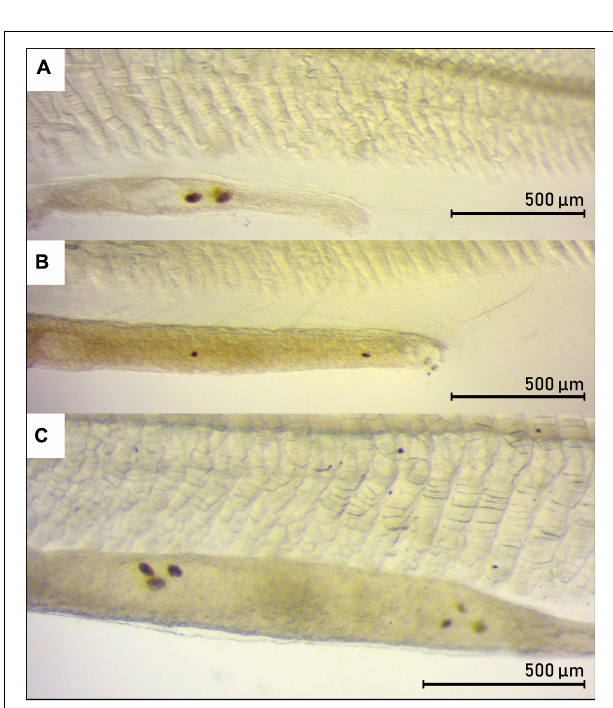
FIGURE 4 | Presence of food-like particles in the intestine of three leptocephalus larvae of the European eel ( Anguilla anguilla ). (A) L9 (SL 10.95 mm), 4.0x. (B) L10 (SL 11.17 mm), 4.0x. (C) L1 (SL 6.97 mm),